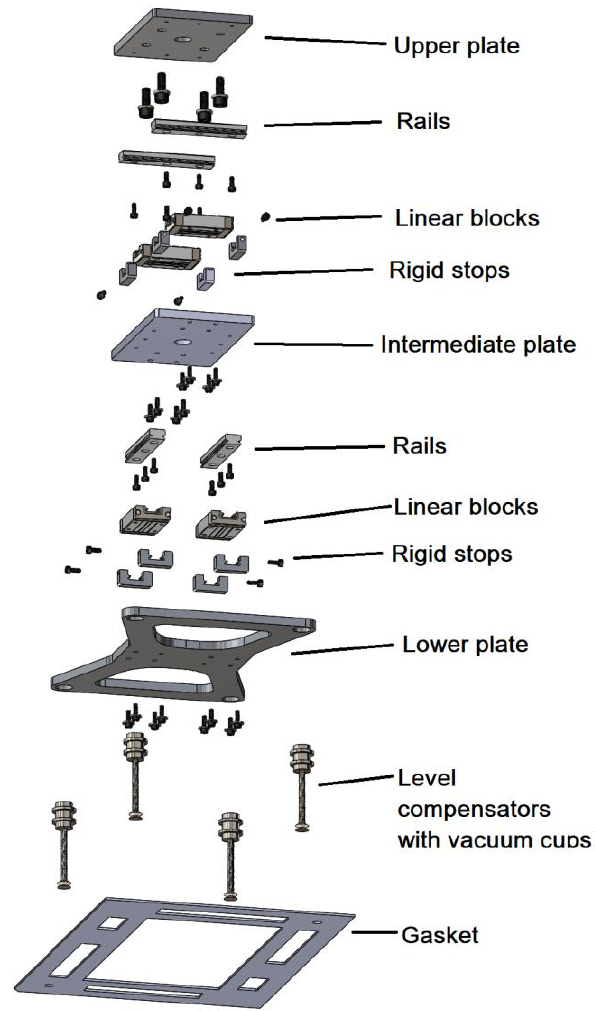
Figure 3. 3D model of the end-effector.